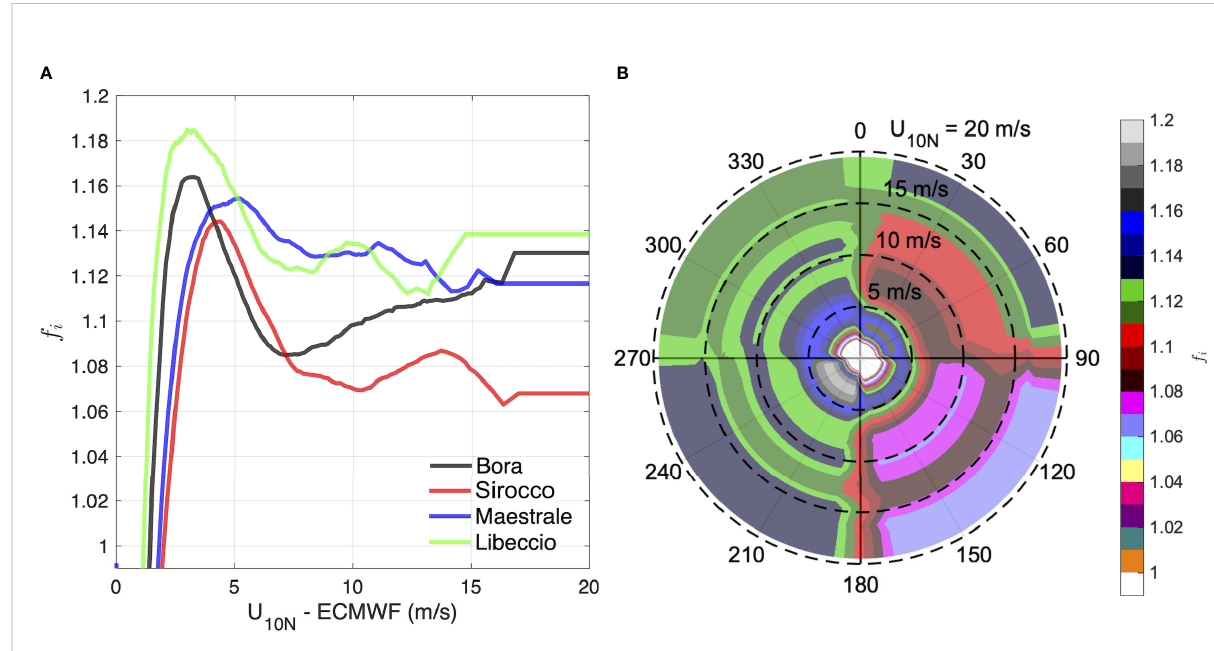
FIGURE 6 GQQM wind speed scaling coef fi cients f i , as a function of wind speed U 10N for the four wind directions (A) and operational implementation over the wind speed and direction (B)